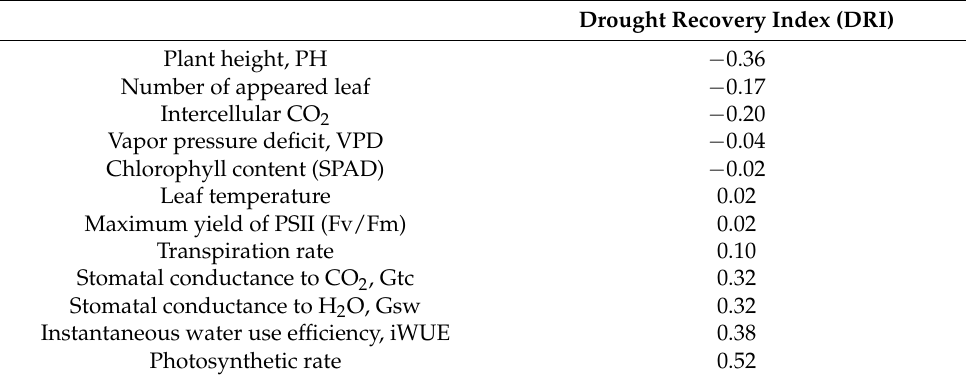
Table 3. Drought recovery index of some morphological and photosynthetic traits.